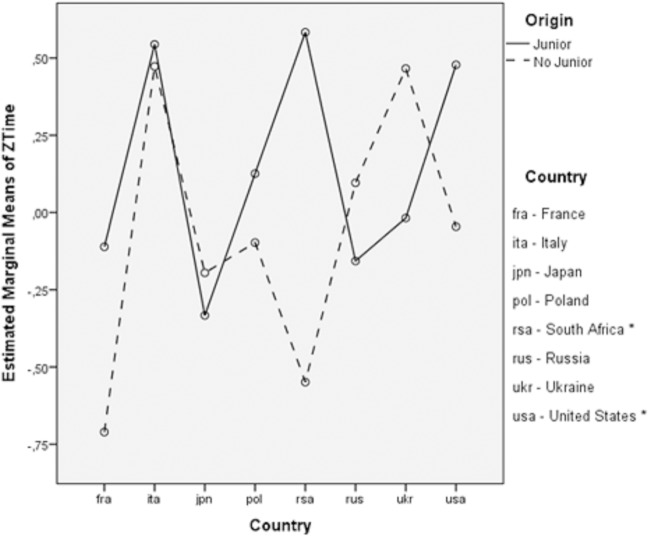
Cumulative percentage plots for Position in separate lines for Origin levels.